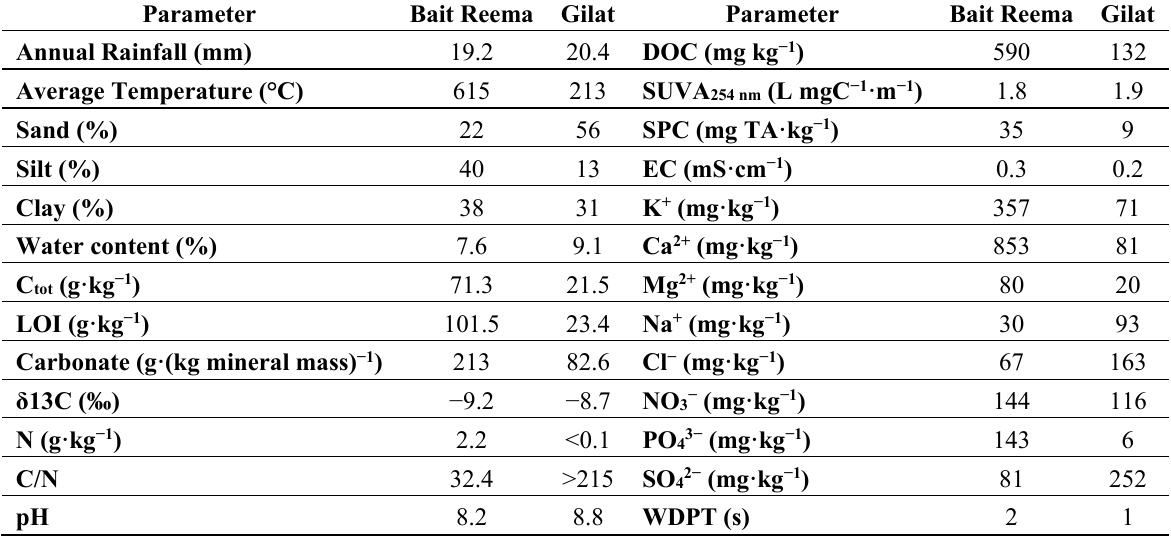
Table 2. Major characteristics of studied fields and chemical properties of soils before amendment with water and OMW. Errors are within the last digit of each